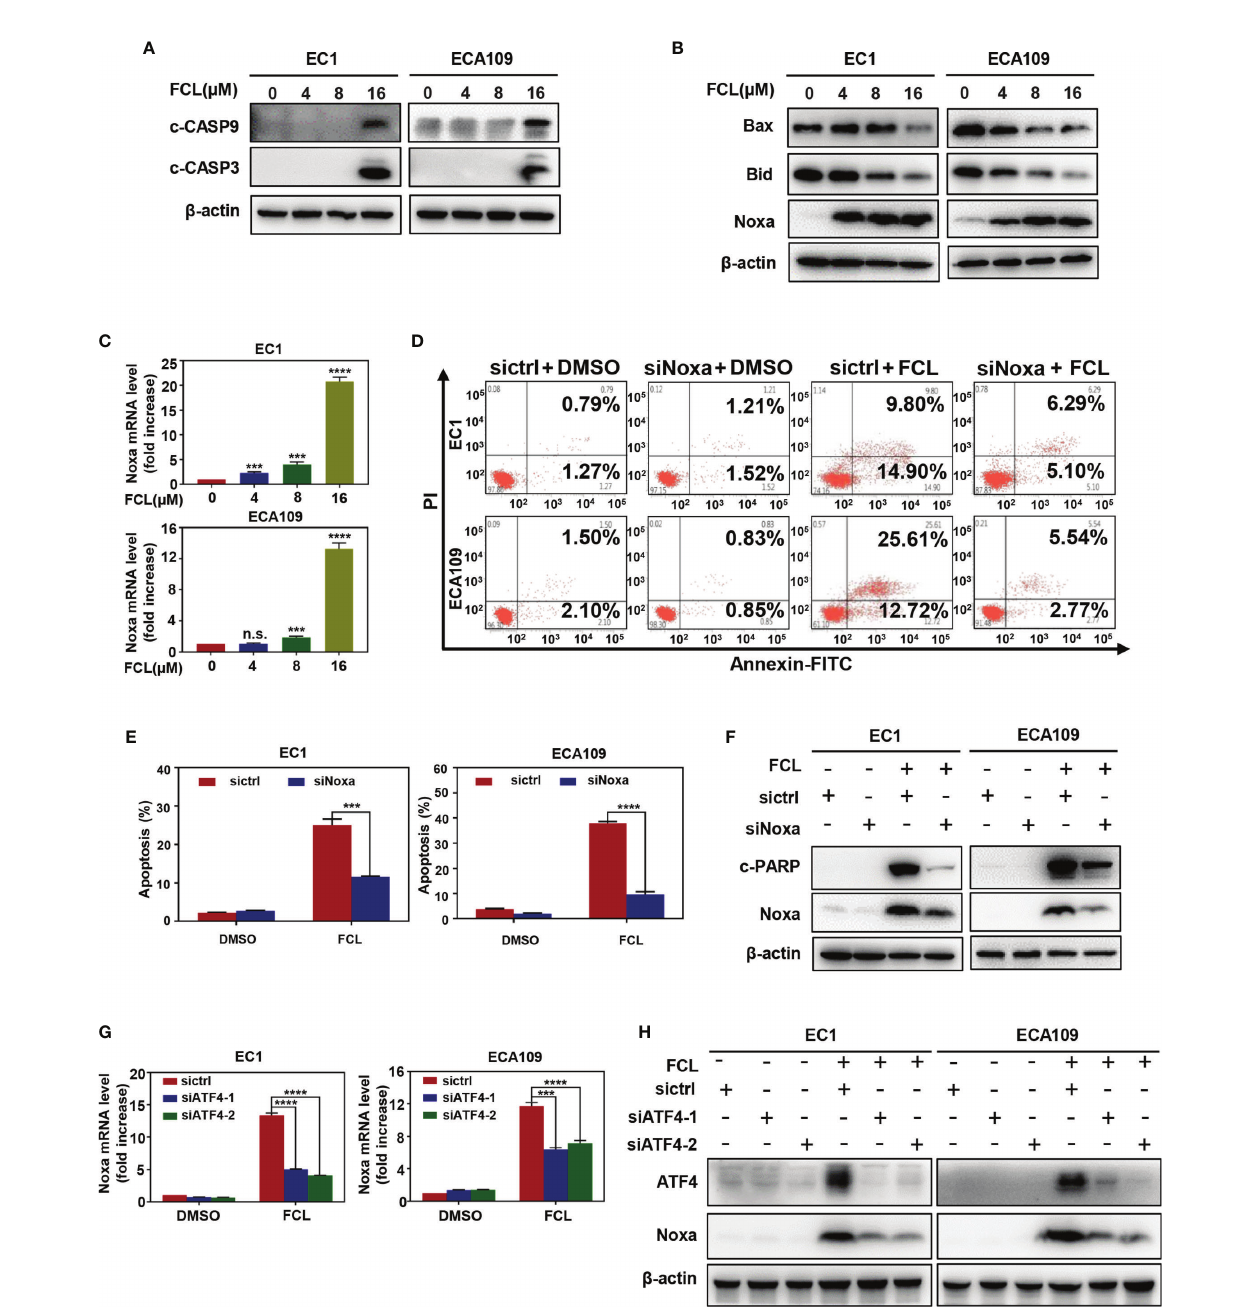
FIGURE 4 | Fangchinoline triggered intrinsic apoptosis via the up ‐ regulation of Noxa. (A) FCL induced the activation of CASP9. EC1 and ECA109 cells were treated with FCL as described above and were subjected to Western blotting using antibodies against c ‐ CASP9 and c ‐ CASP3 with b -actin as a loading control. (B) The expression of classical pro ‐ apoptotic proteins Noxa, Bax and Bid were determined after FCL treatment. EC1 and ECA109 cells were treated with FCL at the indicated concentrations for 24 hours, followed by Western blotting using the indicated antibodies with b -actin as a loading control. (C) FCL increased the mRNA level of Noxa. The mRNA level of Noxa was determined by real-time PCR in EC1 and ECA109 cells. (D, E) Knockdown of Noxa inhibited apoptosis induced by FCL. EC1 and ECA109 cells were transfected with control or Noxa siRNA (72 hours), treated with FCL (16 m mol/L) for 24 hours. Apoptosis induction was quanti fi ed by Annexin V – FITC/PI double-staining analysis. (F) Apoptosis induction was quanti fi ed by Western blotting using an antibody against c ‐ PARP with b -actin as a loading control. (G, H) ATF4 is response for FCL-induced Noxa upregulation. EC1 and ECA109 cells were transfected (72 hours) with control or ATF4 siRNA, treated with FCL (16 m mol/L) for 24 hours. Expression of ATF4 and Noxa were assessed by Western blotting analysis. The effect of ATF4 on Noxa transcription was analyzed by real-time PCR. ***denotes P < 0.001, ****denotes P < 0.0001, n.s. denotes not signi fi